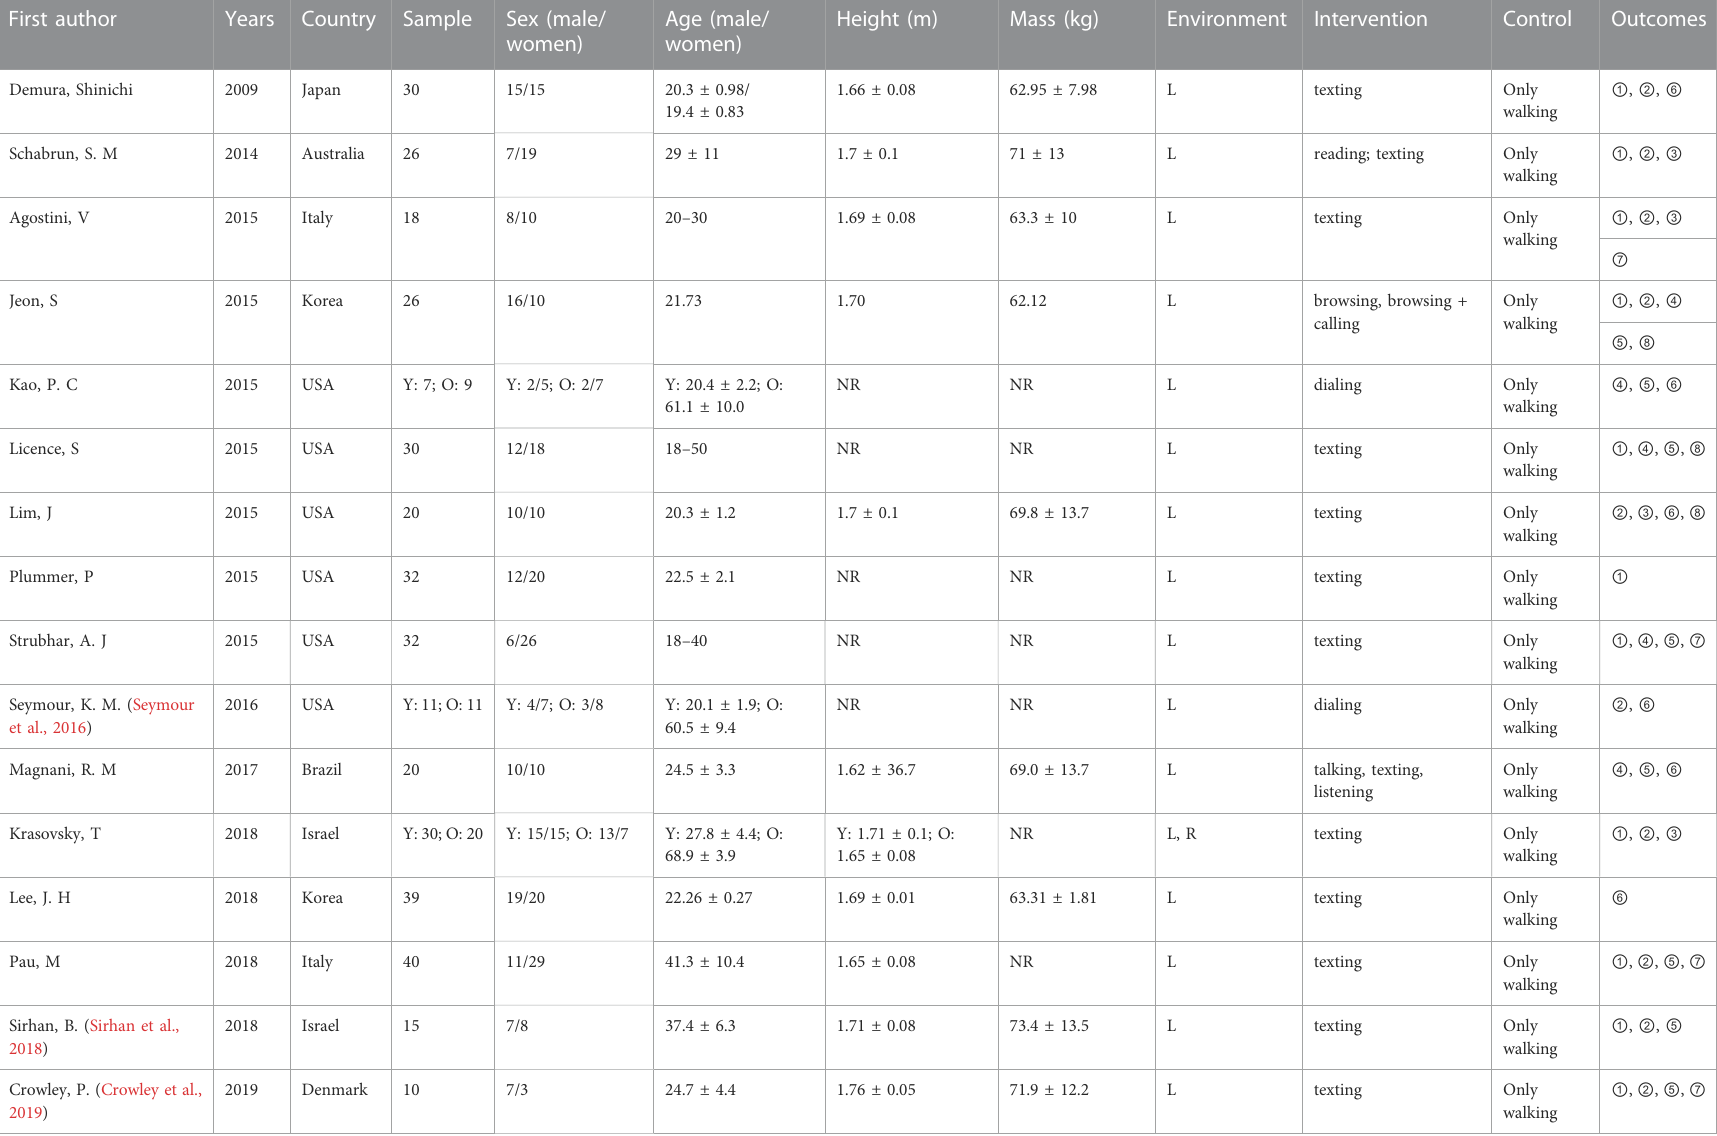
TABLE 1 The detailed characteristics of each included